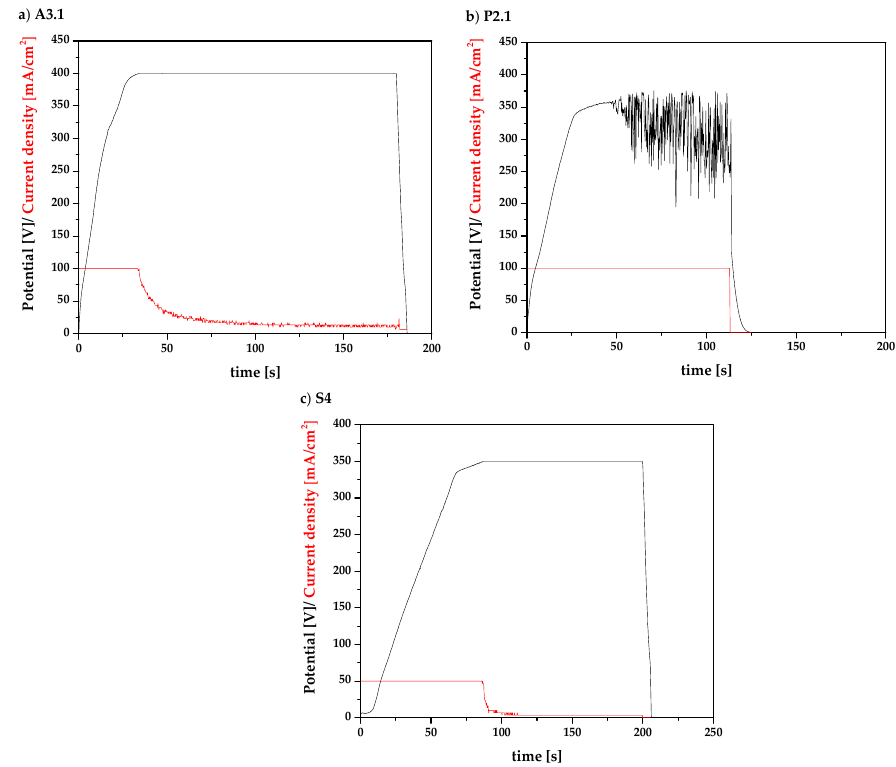
Figure 2. Voltage-current time curves for ( a ) A3.1, ( b ) P2.1 and ( c ) S4 PEO coatings on AA1050 alloy.